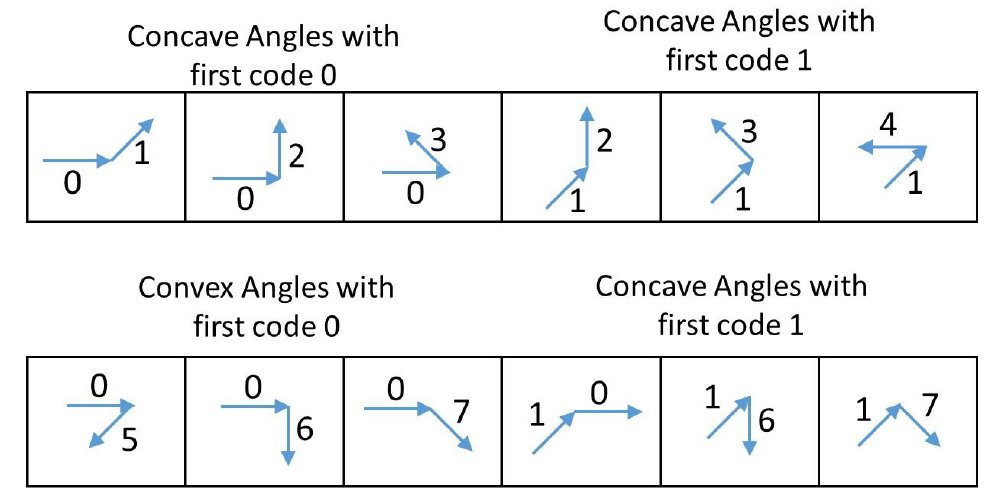
Figure 5. The first row contains six concave angles, and the bottom row contains six convex angles. At each row, the first three angles are characterized by the first code being zero. The last three angles are characterized by the first code being one.